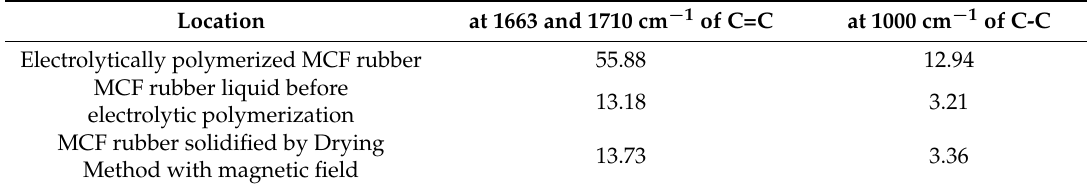
Table 2. Comparison of spectra from Figure 11.